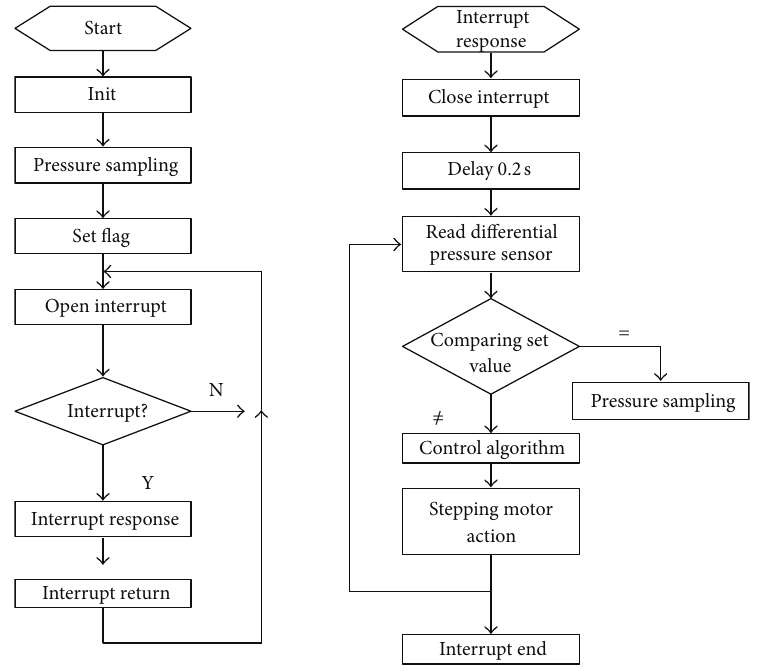
Figure 16: Micro fluid controlling software flow chart.